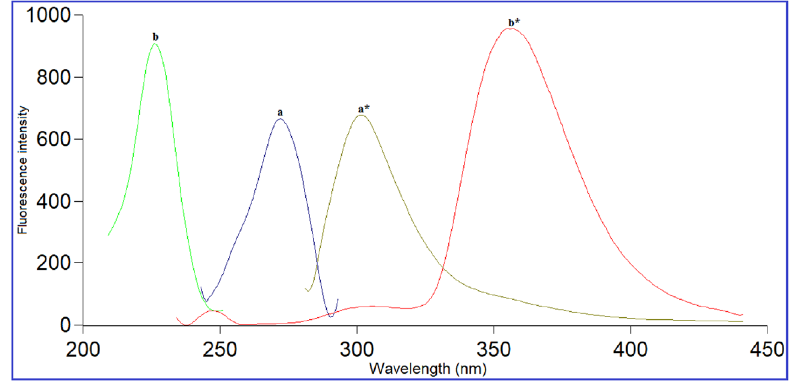
Figure 2. Excitation and emission spectra of VFX (1000.0 ng/mL) (a, a*), and AGM (4.0 ng/mL) (b, b*).